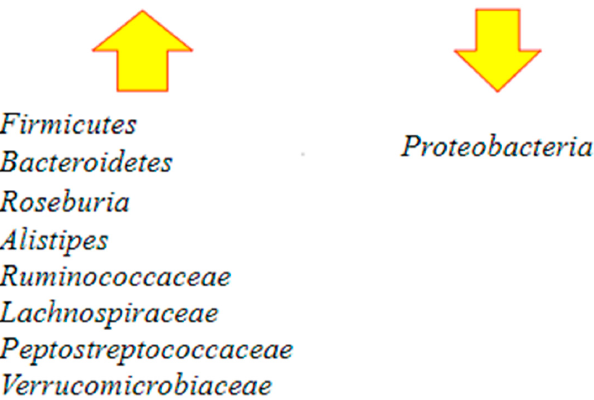
Figure 4. Major changes in the gut microbiota following fecal microbiota transplantation (FMT) [60,62]. After the procedure, there is an increase in the richness and diversity of the microbiome and the restoration of Bacteroidetes and Roseburia , which are involved in butyrate production. There is also restoration of Firmicutes and other protective microbial taxa such as Alistipes , Ruminococcaceae , Lachnospiraceae , Peptostreptococcaceae , and Verrucomicrobiaceae . At the same time, an important de- crease in Proteobacteria occurs.